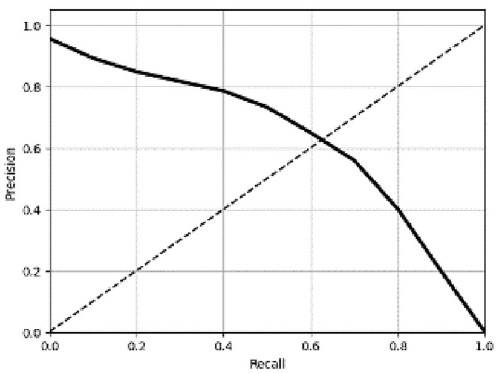
Figure 5. PR curve.